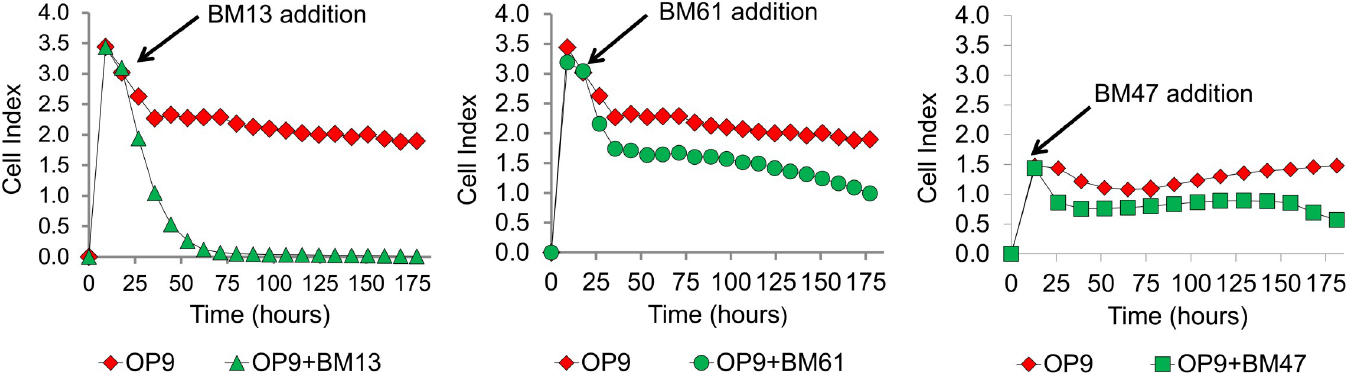
Fig 3. Different BCP-ALL cells exhibit unique patterns of impedance signal displacement. Primary (non-cultured) BCP-ALL samples Ph+ BM61, Ph+ BM13 and BM47 were plated (100,000 cells/well) one day after OP9 feeder cells (10,000 cells/well) and impedance was measured over more than 7 days (n = 2). BM13 and BM61 were run on the same plate, whereas BM47 was from a different